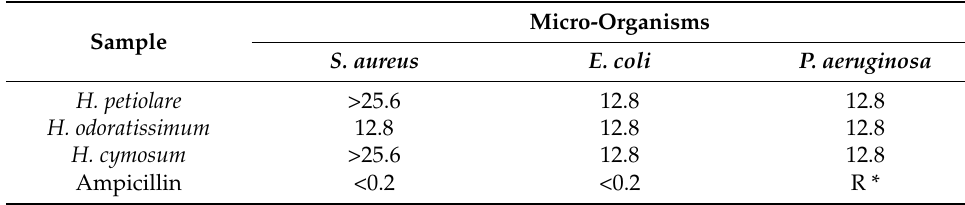
Table 5. MICs (mg/mL) of Helichrysum EOs and control.